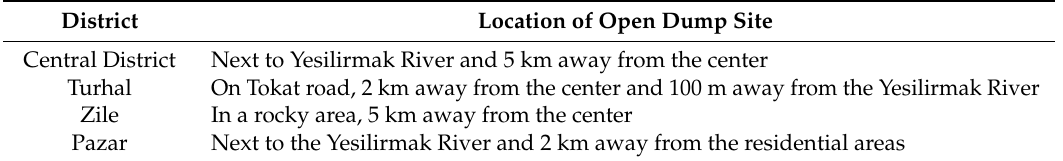
Table 1. Information concerning open dumping practices.